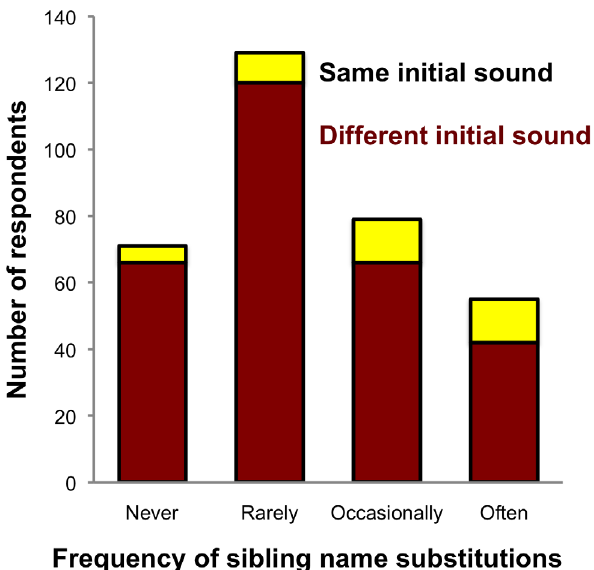
Figure 1. Frequency distribution of respondents with and without the same initial phoneme in their names as their closest sibling in age across the reported lifetime frequency of name substitutions made by their parents.